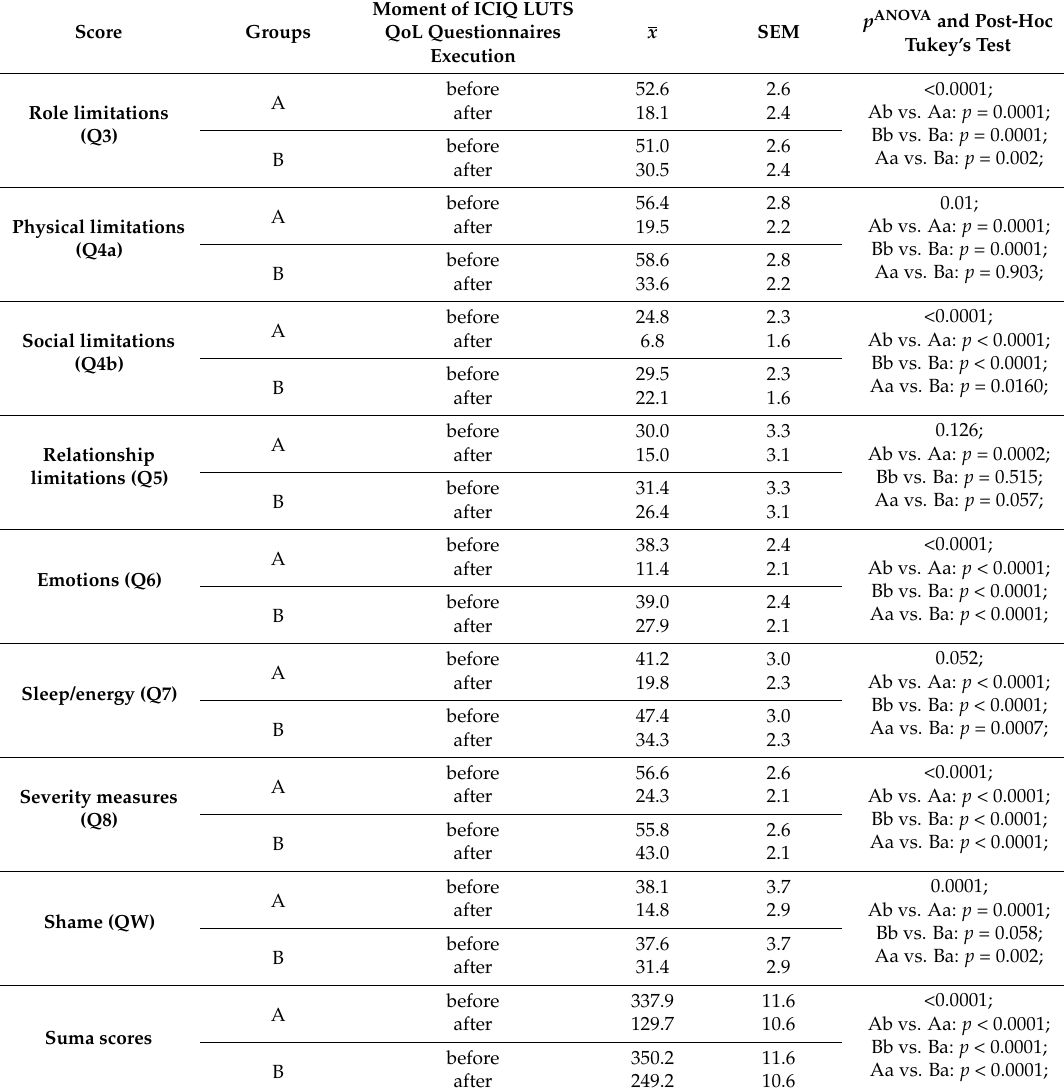
Table 2. A two-way analysis of variance (group × time) for the International Consultation Incontinence Questionnaire Lower Urinary Tract Symptoms quality of life (ICIQ LUTS